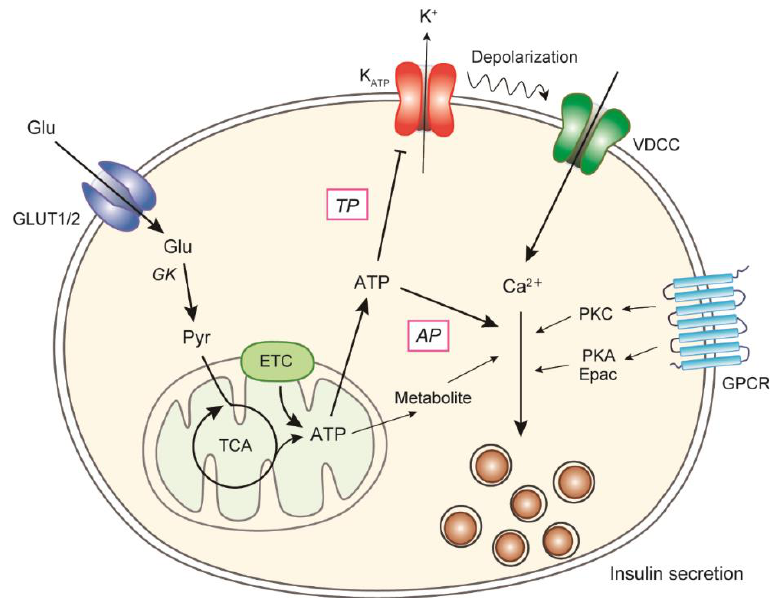
Figure 1. Mechanism of glucose-induced insulin secretion in β - cells. Insulin secretion from β -cells is regulated by intracellular glucose metabolism, and glucose-induced ATP production in mitochondria plays an essential role. Increased ATP levels in β -cells lead to the closure of K ATP channels, followed by membrane depolarization and the subsequent activation of VDCCs. An elevation of intracellular Ca 2+ levels triggers the exocytosis of insulin granules. The triggering pathway is critical for GSIS and is modulated by the signals of various GPCRs. In addition, ATP and other metabolites amplify downstream of Ca 2+ influx in the triggering pathway (the amplifying pathway). Glu, glucose; GK, glucokinase; Pyr, pyruvate; ETC, electron transport chain; TP, the triggering pathway; AP, the amplifying pathway.